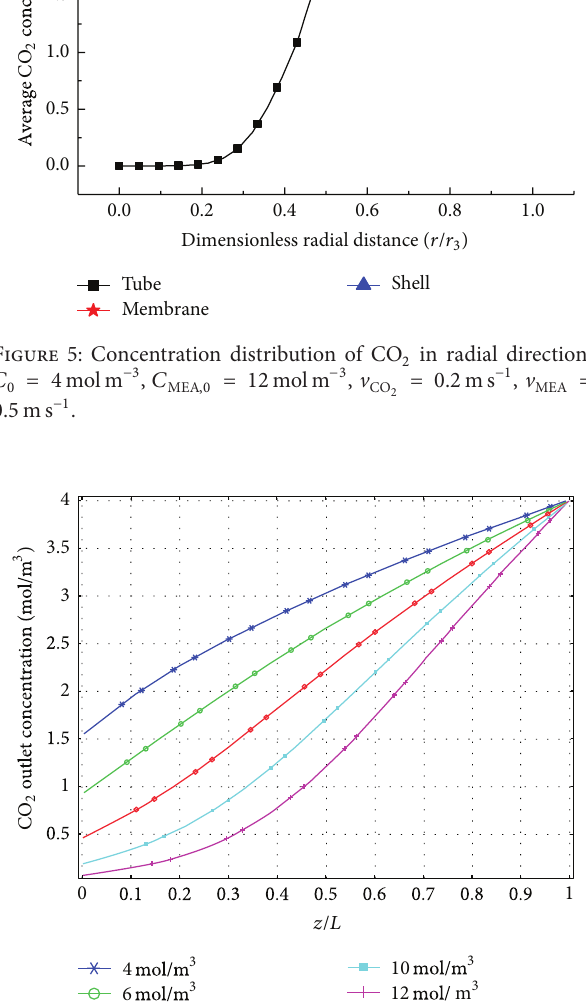
Figure 6: CO 2 concentration distribution along the membrane length. 𝐶 0 = 4 mol m −3 , V